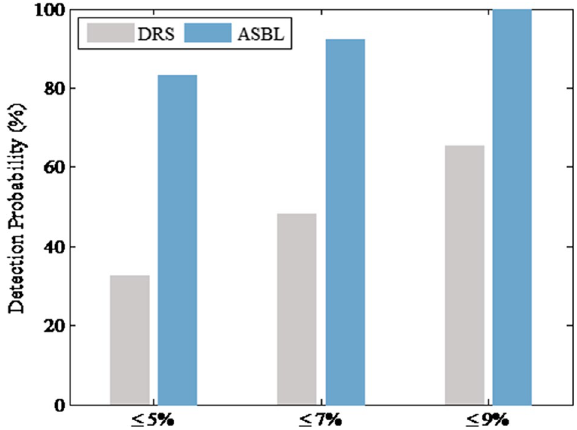
Fig. 13 ASBL and DRS positioning probability